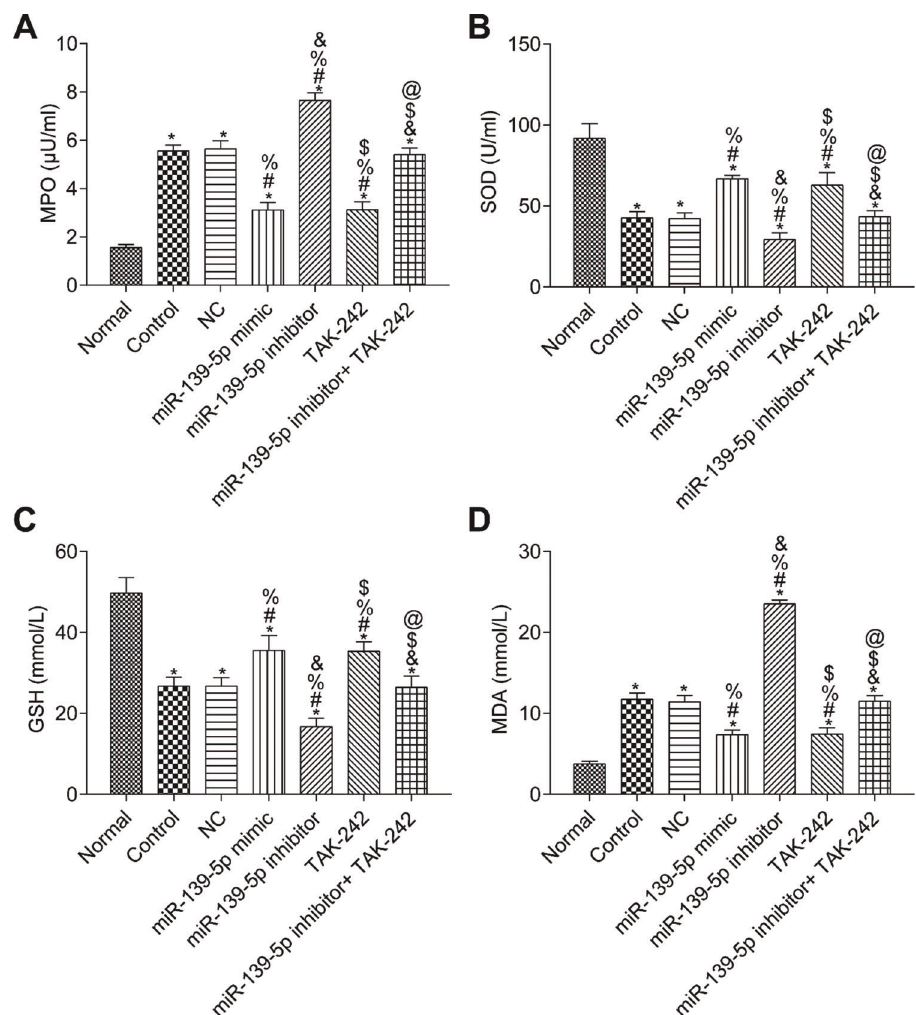
Figure 5 - Levels of MPO (A), SOD (B), GSH (C), MDA (D) in the lung tissue of mice in each group. Significant comparisons with each group, where p o 0.05, are indicated by: ‘‘ * ’’ for the Normal group, ‘‘ # ’’ for the Control group, ‘‘ % ’’ for NC group, ‘‘ & ’’ for the miR-139- 5p mimic group, ‘‘ $ ’’ for the miR-139-5p inhibitor group, and ‘‘ @ ’’ for the TAK-242 group. MPO, myeloperoxidase; SOD, superoxide dismutase; GSH, glutathione; MDA,